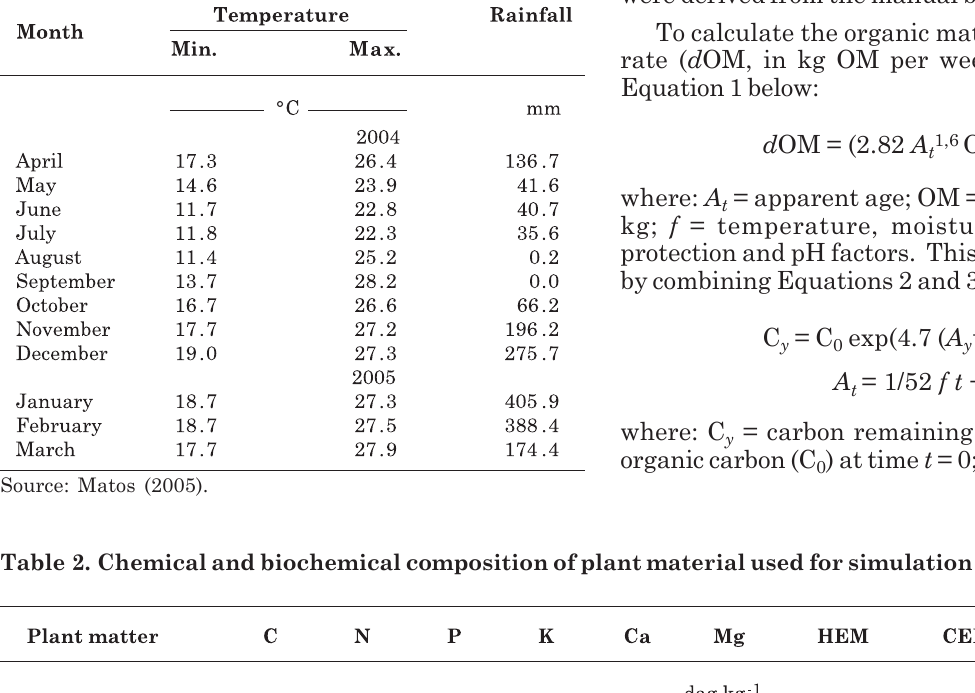
Table 1. Average minimum and maximum temperatures and monthly rainfall in a 1-year period in the municipality of Pedra Dourada